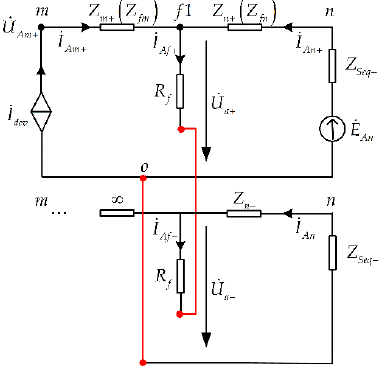
Figure A1. Compound sequence network under a phase B-to-phase C fault at f1.